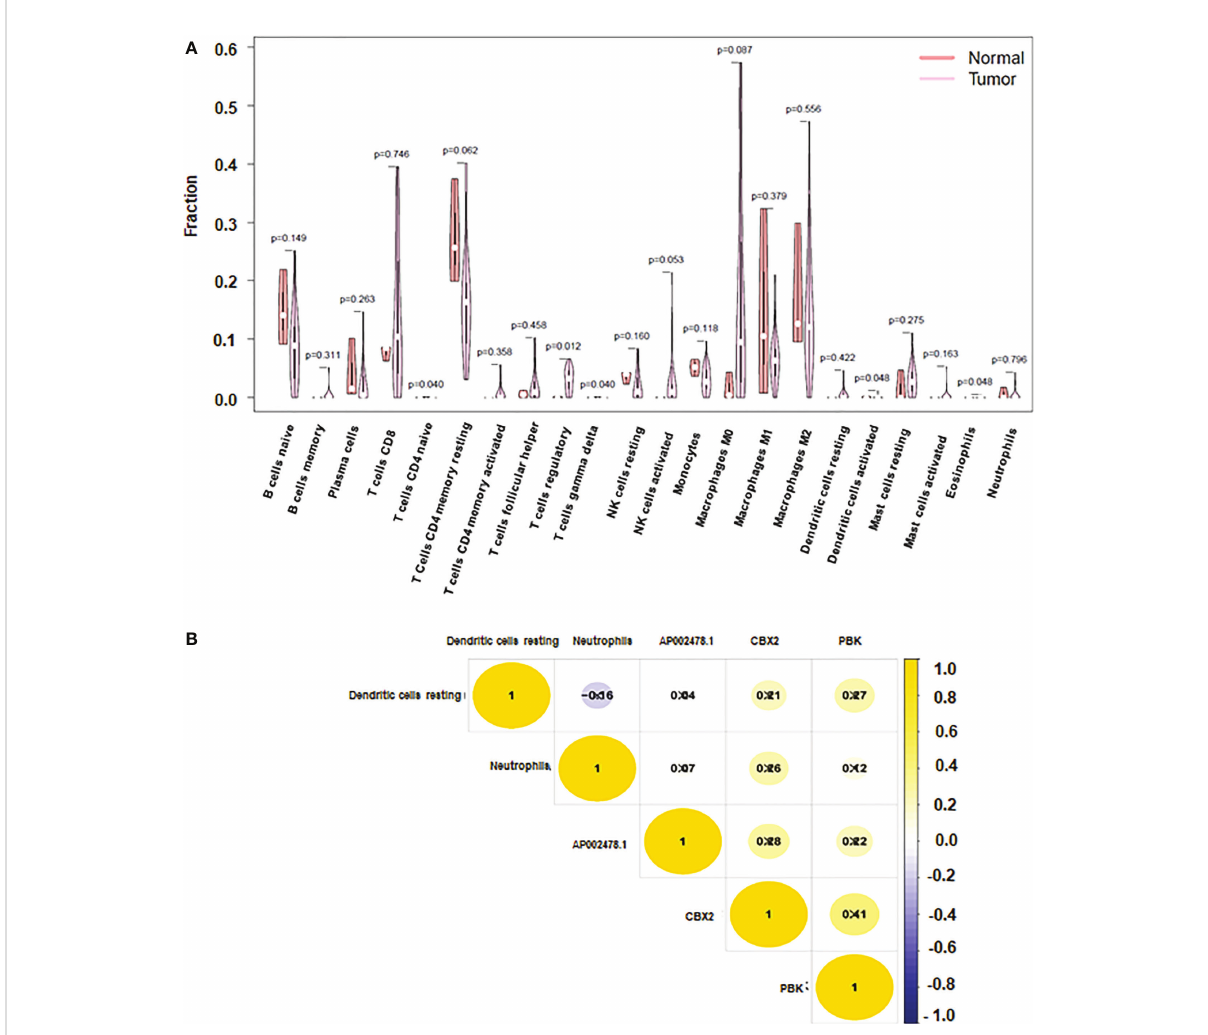
FIGURE 7 Immune cells and CBX2, PBK, AP002478.1 in HCC. (A) Heatmap of the three immune cells in the Cox regression model. (B) correlation between immune cells and